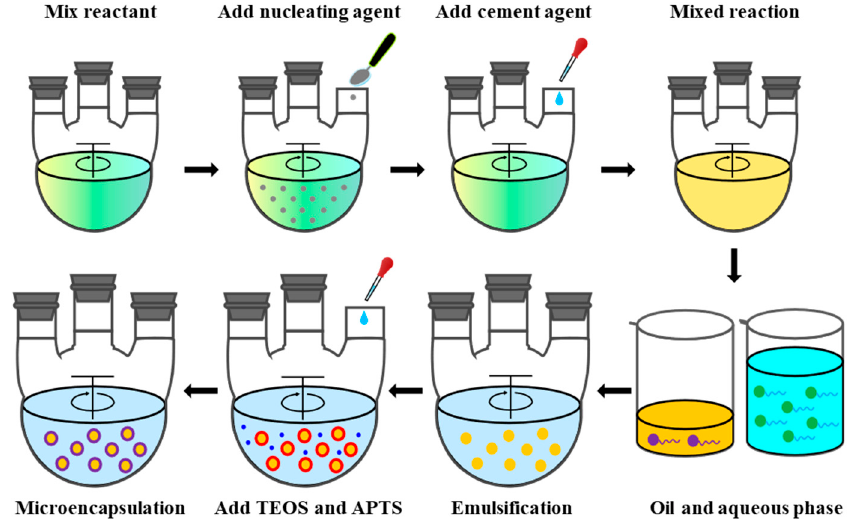
Figure 2. Typical preparation procedure of nano-silica/modified n-alkane